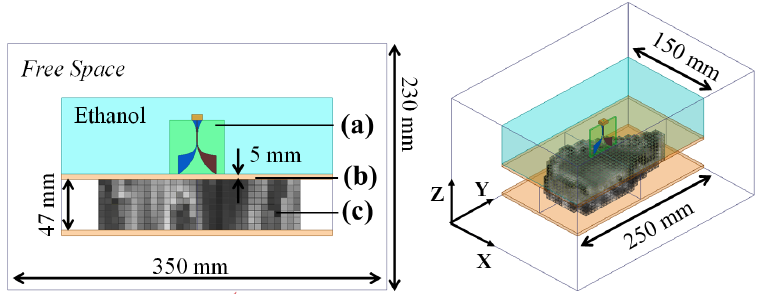
Figure 12. Simulation geometry in HFSS: ( a ) AVA, ( b ) acrylic sheet, ( c ) compressed breast model discretized into tiny cubes of 6 mm sides. On the right, an isometric view of the configuration is displayed.